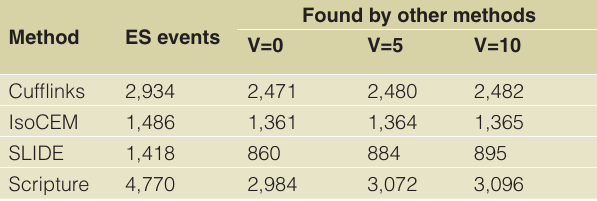
Table S7. Reproducibility of exon skipping (ES) discovery from transcripts assembled with different methods, and robustness with varying cutoffs (V bp) for the margin of error when comparing exon and intron boundaries.